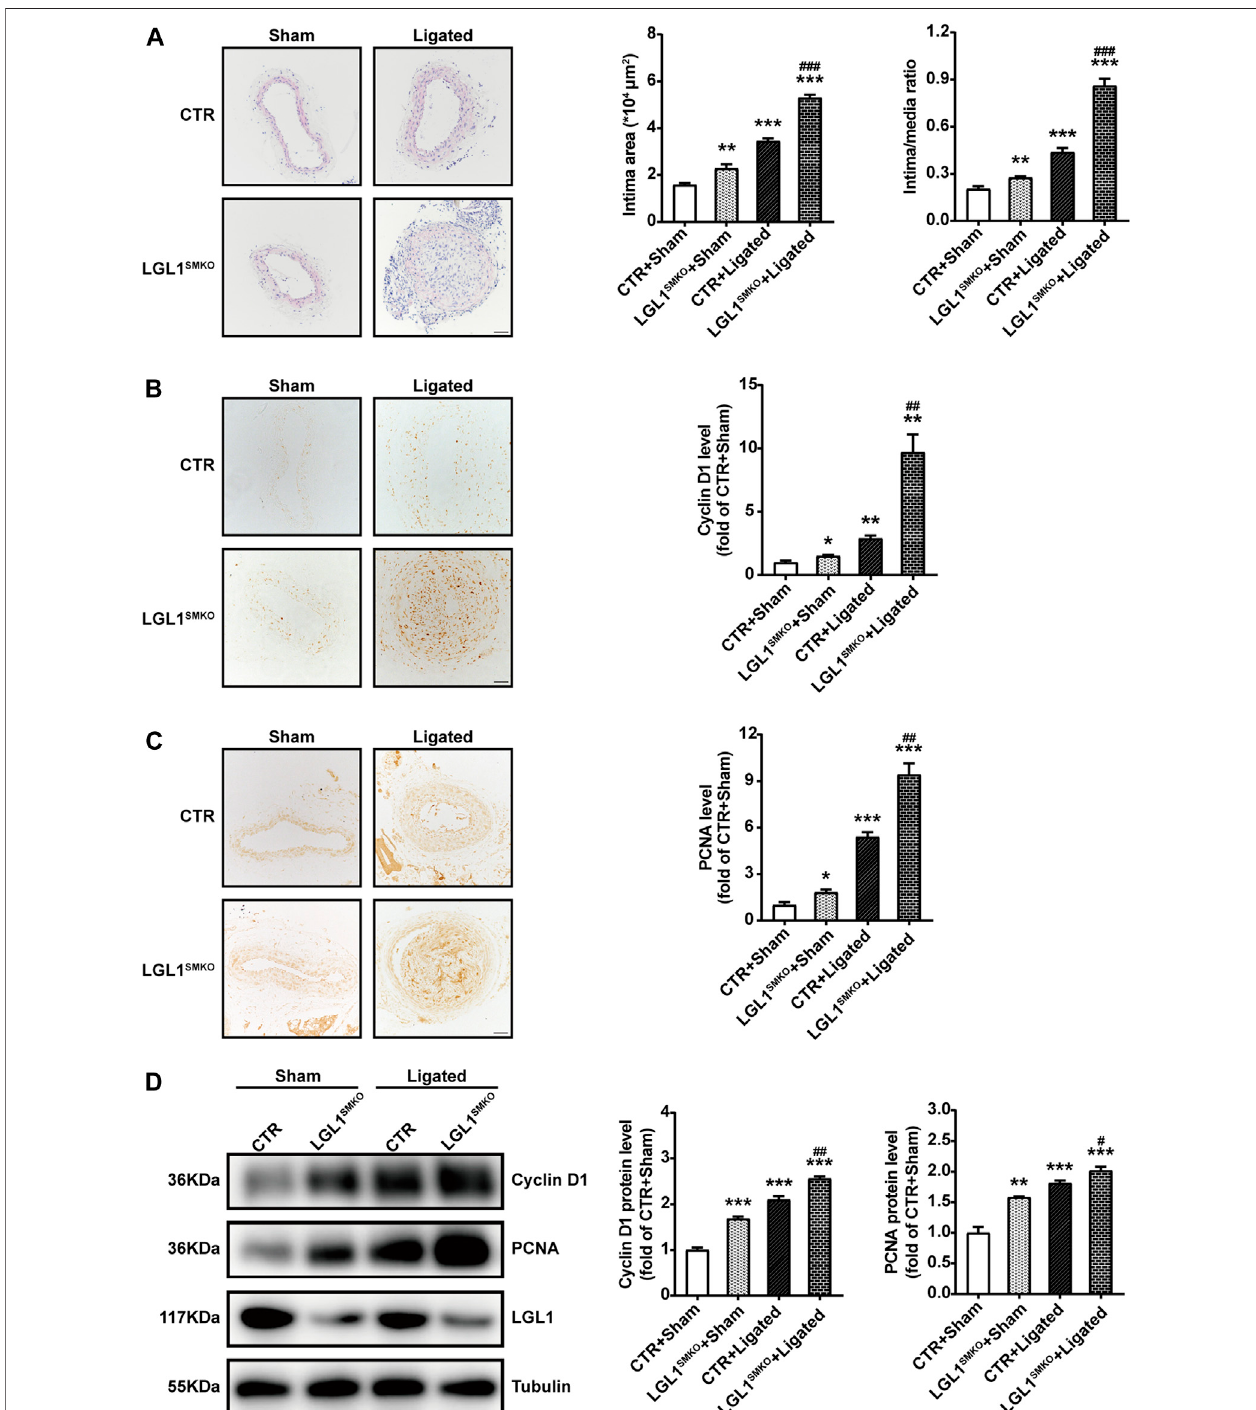
FIGURE 6 | Smooth muscle-speci fi c deletion of LGL1 promoted neointimal hyperplasia via STAT3. (A) Control (CTR) and LGL1 SMKO mice underwent left CCA ligation(Ligated)toinduceneointimalhyperplasia;rightCCAwasappliedascontrol(Sham).CarotidarterieswerestainedwithHE.Theintimalareaandintima/mediaratio werecalculated( n =6).Scalebar:50 μ m. (B,C) CyclinD1 (B) andPCNA (C) levelstestedbyimmunohistochemistry( n =3).Scalebar:50 μ m. (D) ProteinlevelsofCyclin D1 andPCNA detected bywesternblotanalysis( n =4). * p < 0.05, ** p < 0.01, *** p < 0.001 vs. CTR+Sham. # p < 0.05, ## p < 0.01, ### p < 0.001 vs. CTR+Ligated.